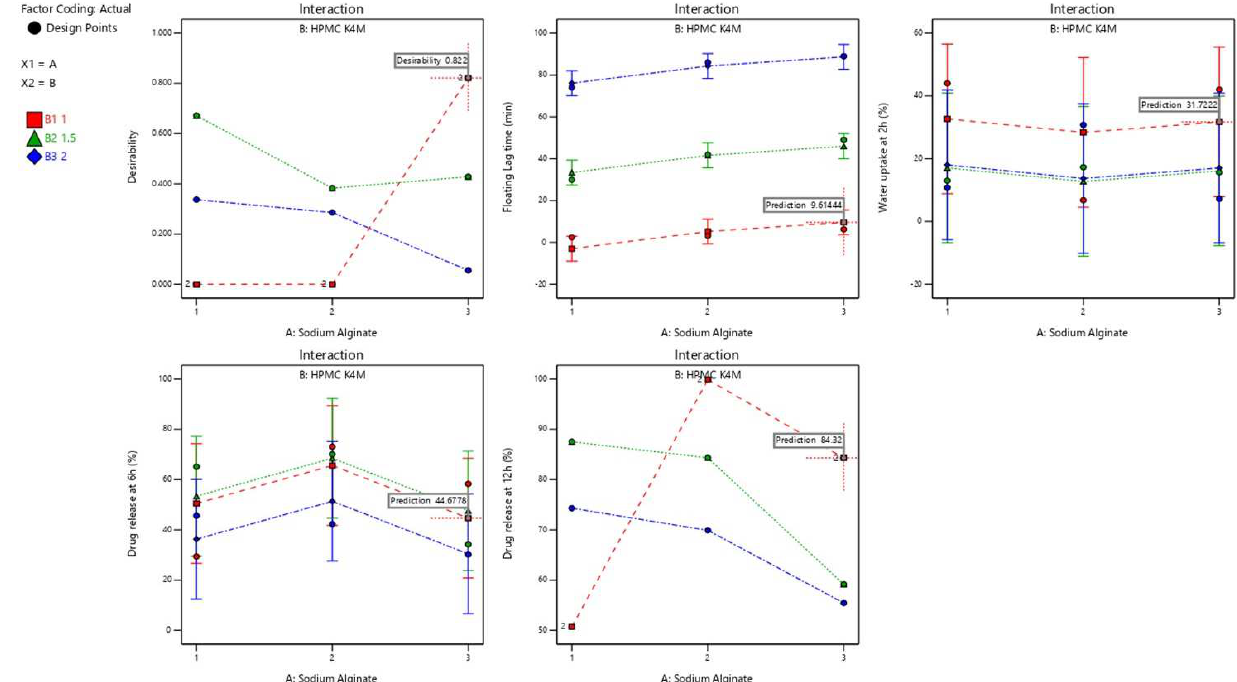
Figure 8. Optimization of the oral raft-forming in situ gelling system of NTB, represented by desir-